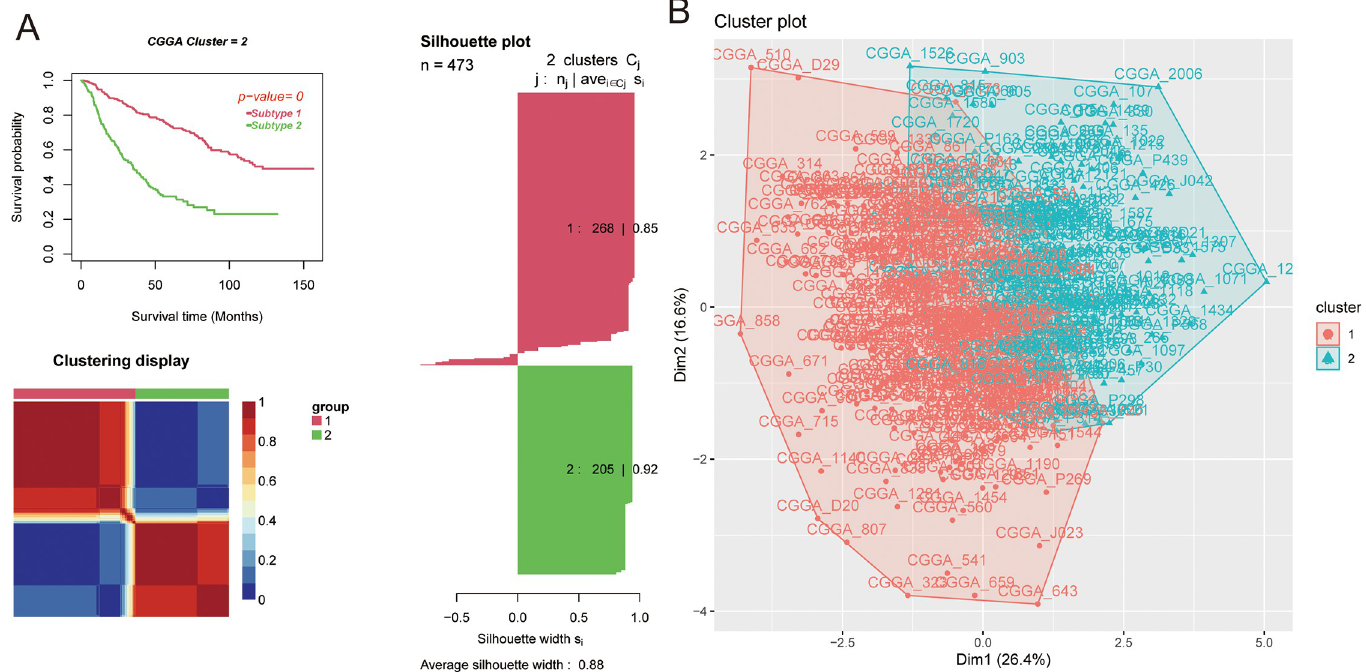
Fig 2. Identification of RNA modification "writer" molecular subtypes. (A) Kaplan–Meier survival analysis of two subtypes with log-rank test p value; clustering heatmap of two subtype samples; average silhouette width representing the coherence of clusters. (B) Principal component analysis shows that the two subtypes have significant differences in the